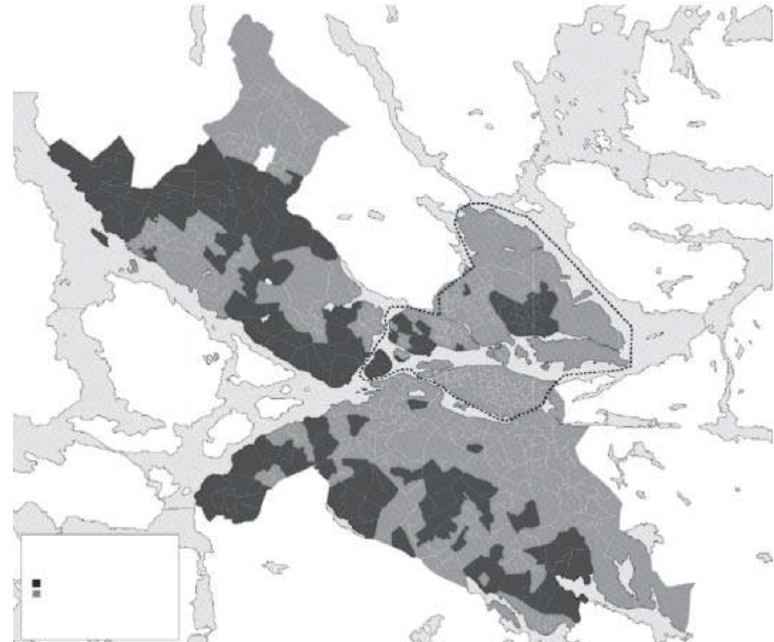
Figure 2. Results from the Stockholm referendum on congestion charging in 2006, 52% for and 48% against. Note: City of Stockholm residents only; charging cordon noted as a dotted line. “No” districts noted in the darker shade. Those within the cordon were in general far more favorable to the charge than those outside the cordon. Roughly half of the revenues come from residents within the cordon (Hårsman & Quigley,